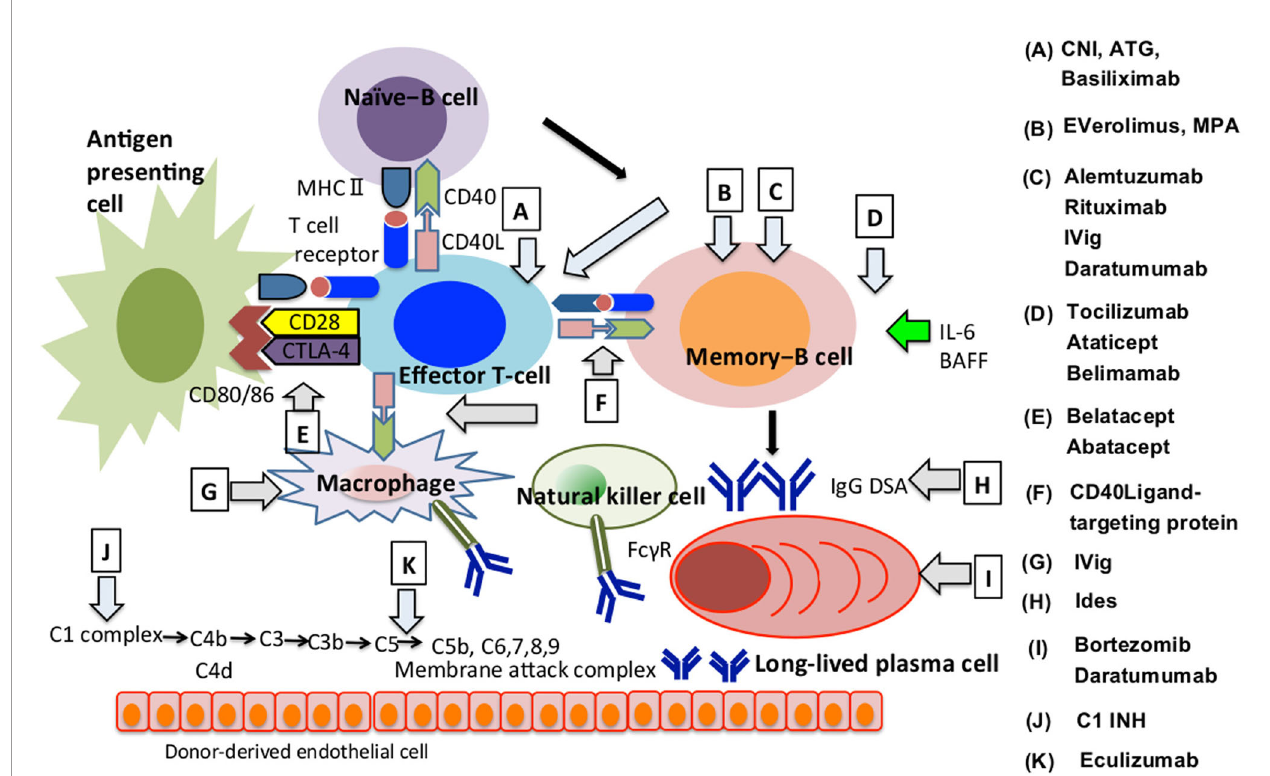
FIGURE 2 | How immunosuppressive agents in fl uence the AMR development. We summarised how immunosuppressants are involved in regulating AMR onset at each B cell differentiation stage, direct or indirect involvement of T cells, macrophages or natural killer cells and the complement system. The alphabet represents immunosuppressants that are effective in the differentiation process indicated by arrows. AMR, Antibody-mediated allograft rejection; ATG, Antithymocyte globulin; BAFF, B Cell Activating Factor; CD40L, CD40 ligand; CTLA-4, Cytotoxic T-lymphocyte associated antigen 4; DSA, Donor-speci fi c HLA antibody; Fc g R, Fc gamma receptor; C1 INH, Human plasma-derived C1 esterase inhibitor; CNI, Calcineurin inhibitor; Ides, IgG-degrading enzyme of streptococcus pyogenes ; IVig, Intravenous Immunoglobulin; MHC, Major histocompatibility complex; MPA, mycophenolic